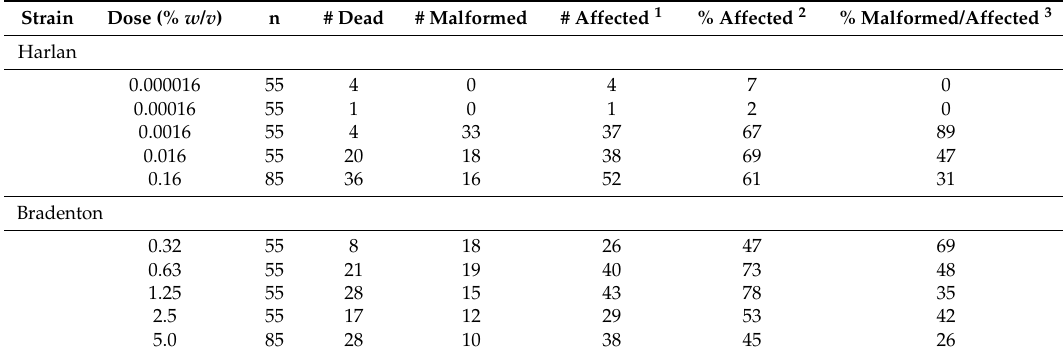
Table 1. Malformations and mortality of Harlan and Bradenton strain bed bugs following topical application of lufenuron for each tested dose.